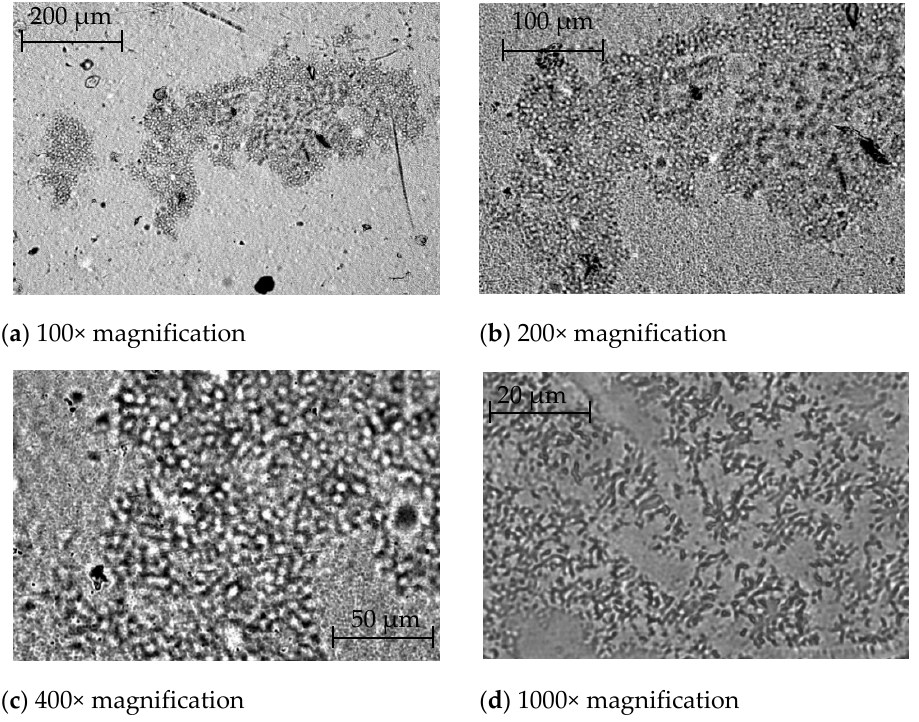
Figure 4. Microphotographs of the sample surface of LDPE film modified with betulin at different magnifications.